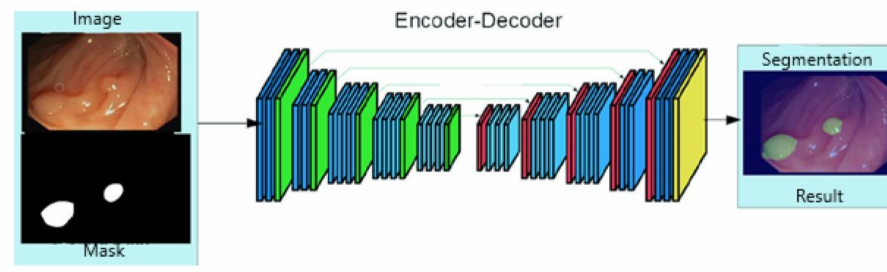
Figure 4. ResNet18 model architecture